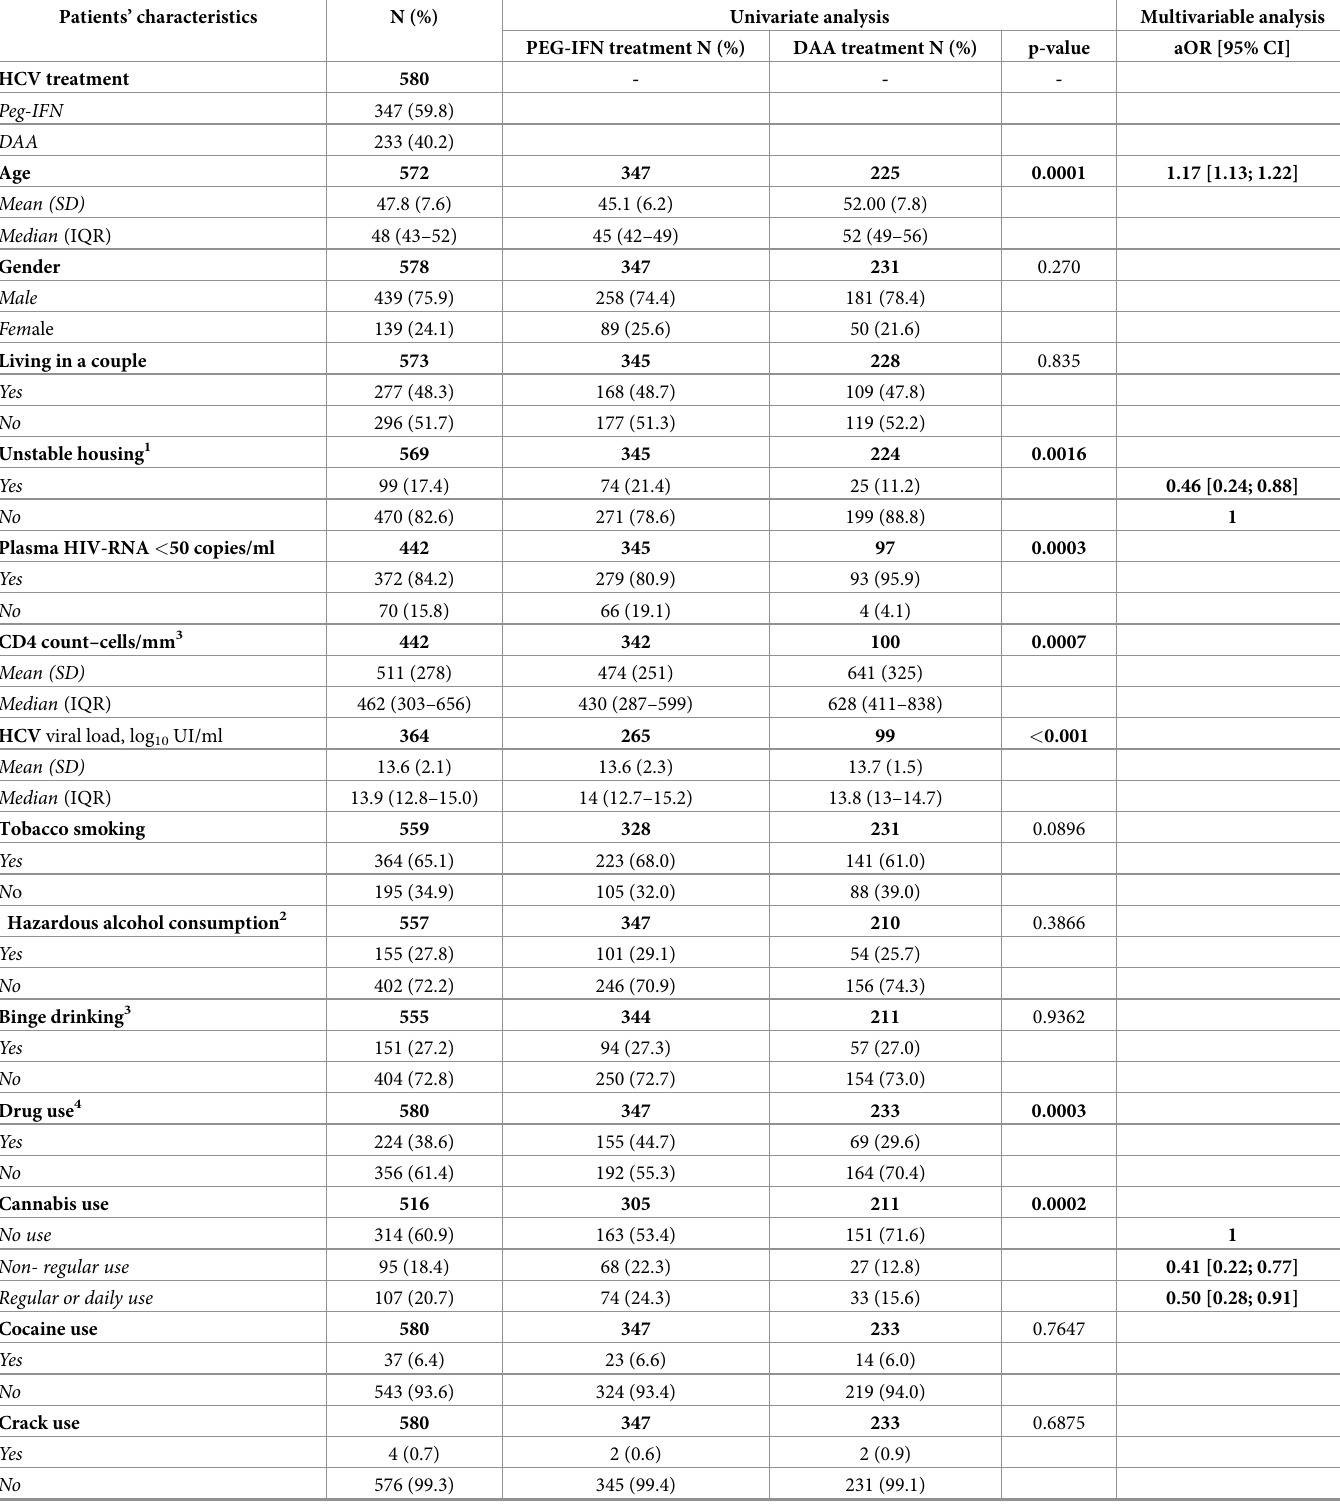
Table 1. Comparison of patients’ socio-behavioral profiles at HCV treatment initiation in the ANRS CO13 HEPAVIH cohort (N = 580). Patients’